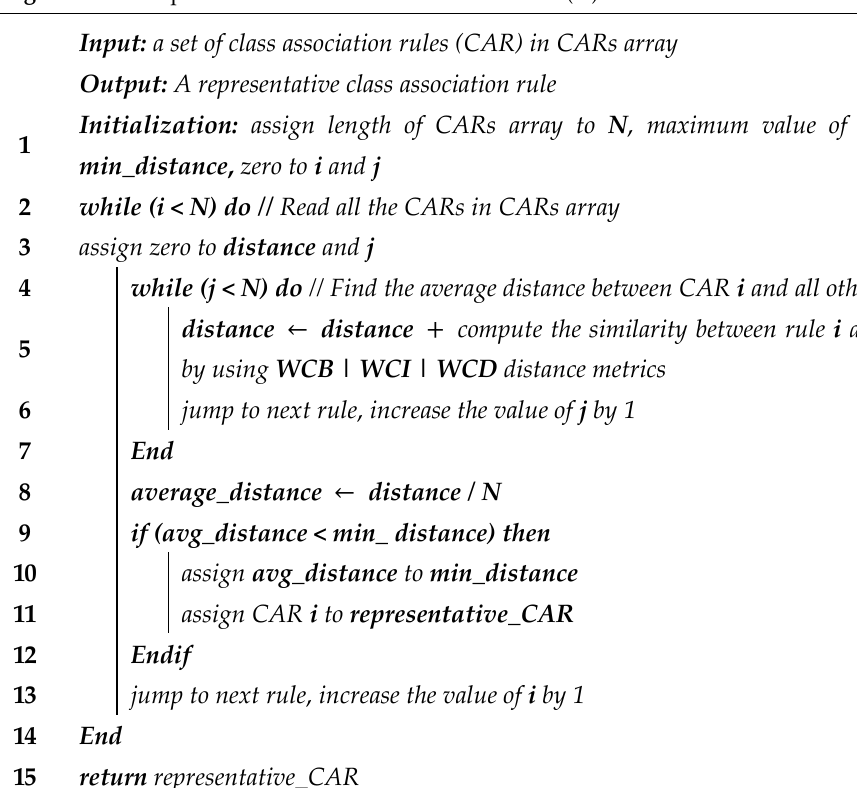
Algorithm 1 A representative car based on cluster center (rc)